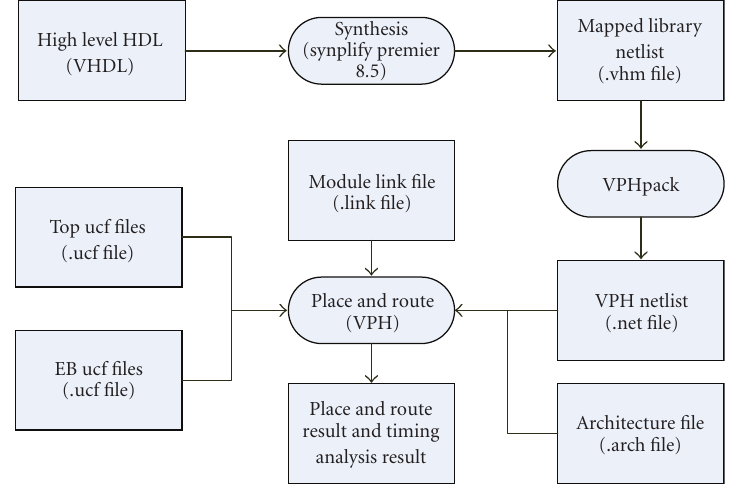
Figure 7: Design flow of exploration using VPH.